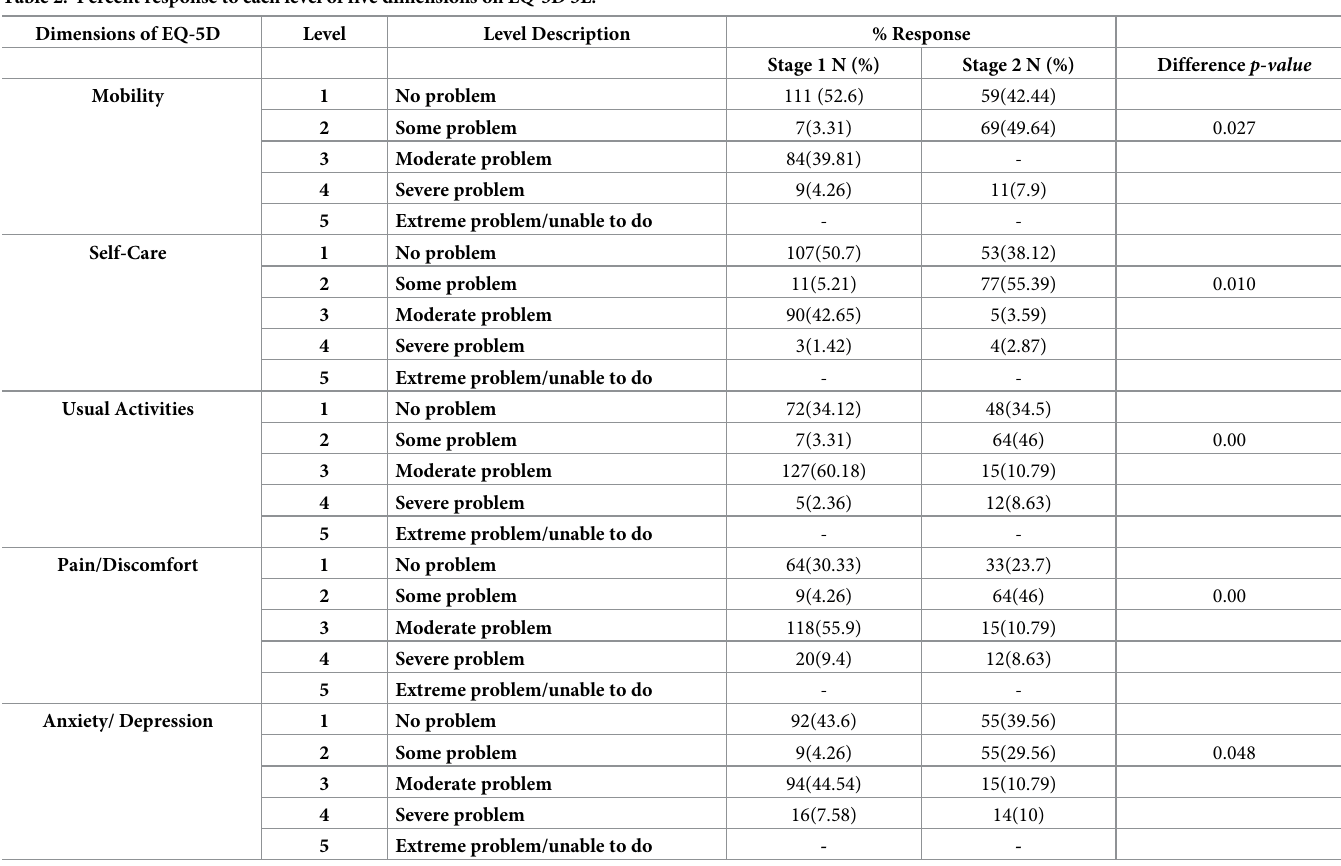
Table 2. Percent response to each level of five dimensions on EQ-5D 5L.